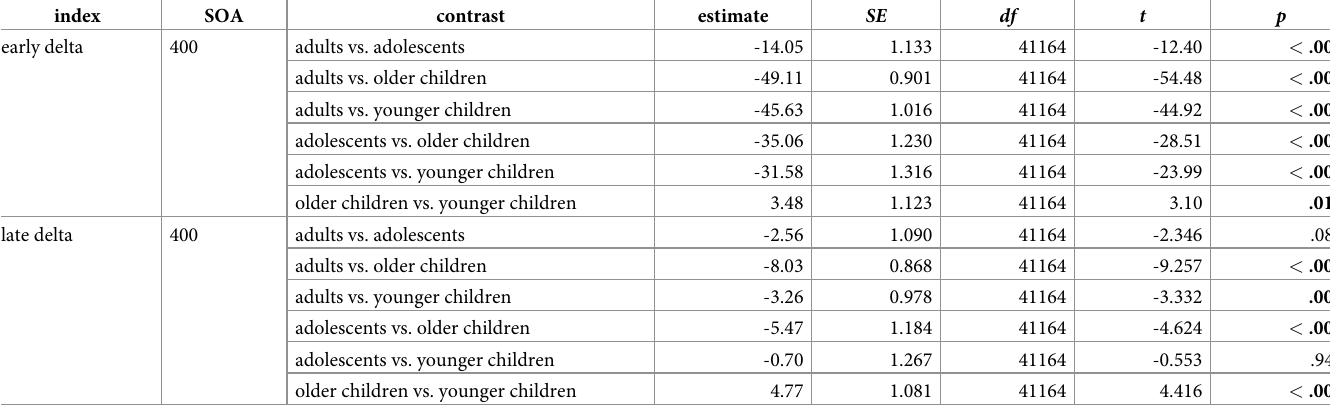
Table 3. Post-hoc contrasts of the age group × SOA interaction effect of the early and late delta scores models.